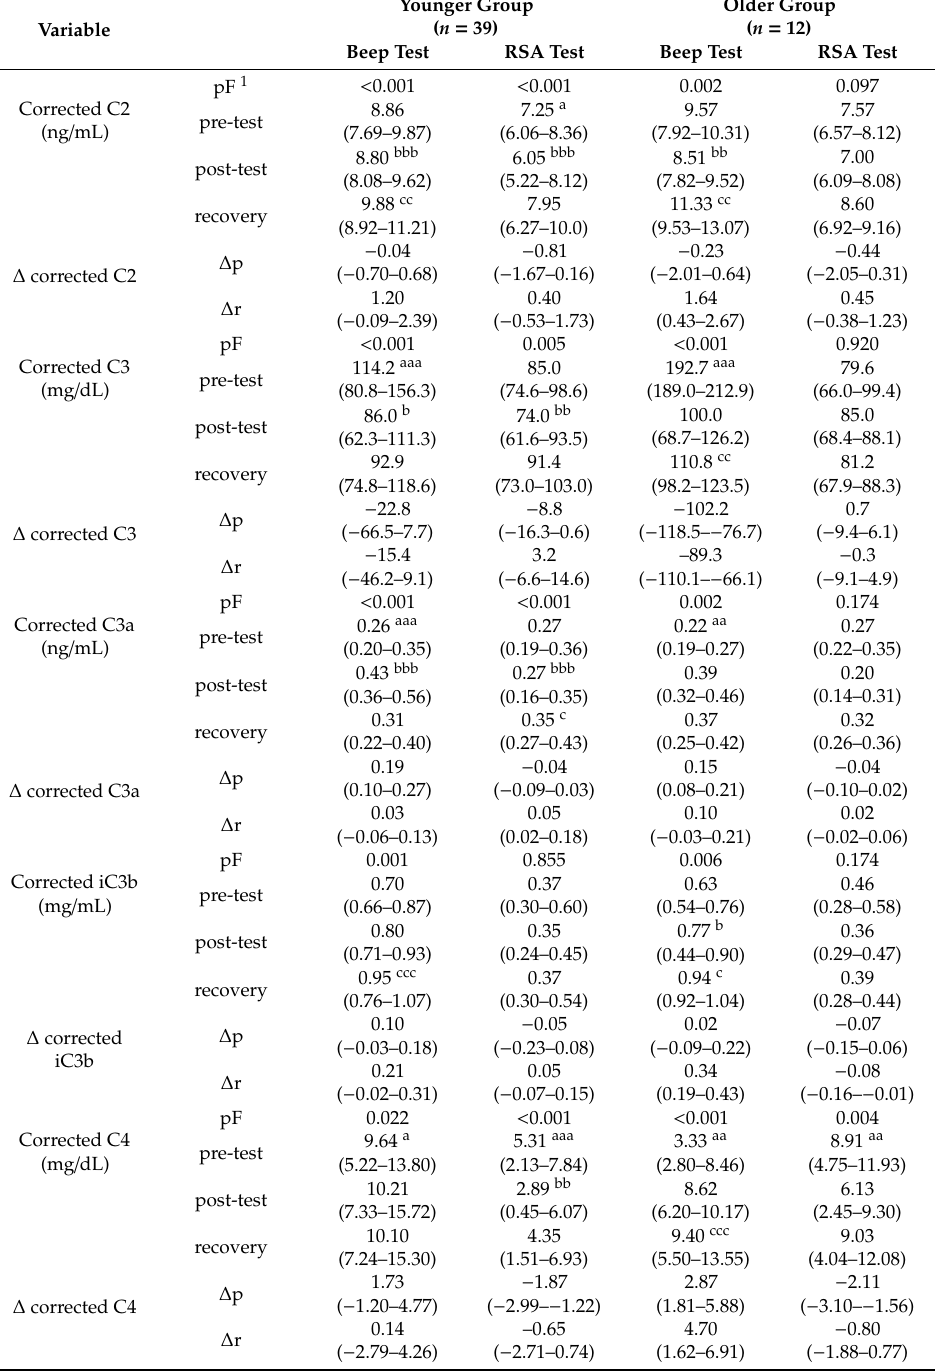
Table 4. Complement variables of studied participants’ blood